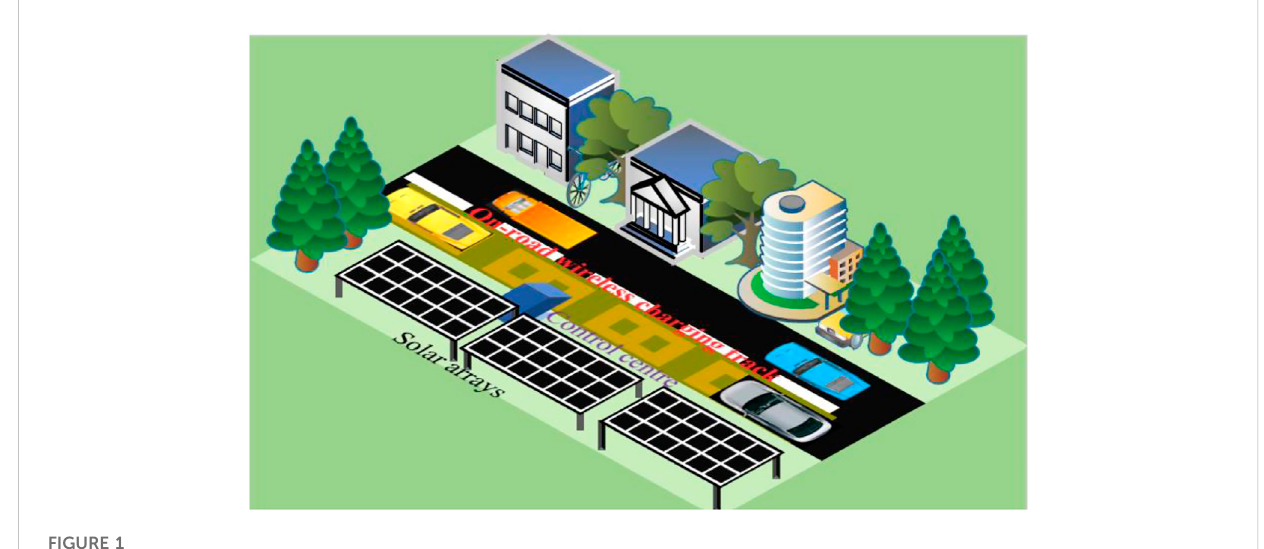
FIGURE 1 Representation of PV-integrated DWPT system.